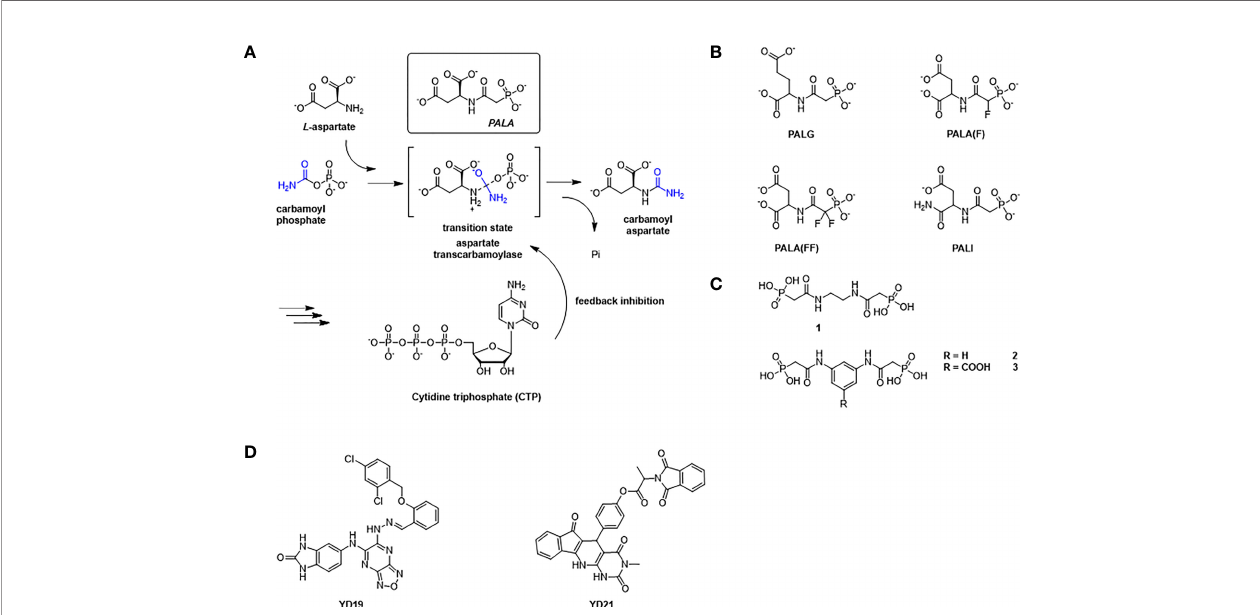
FIGURE 2 | The reaction catalyzed by ATCase and feedback regulation mechanism in de novo pyrimidine biosynthesis pathway, and inhibitors against ATCase. (A) Aspartate Transcarbamoylase (ATCase) combines L-aspartate and carbamoyl phosphate into carbamoyl aspartate through an enzyme stabilized transition state and inhibition feedback by CTP. The ATC inhibitor PALA closely resembles this transition state intermediate. CTP (a product of the pyrimidine biosynthesis pathway) provides feedback inhibition of ATC activity. (B) Structures of PALA analogues as E. coli ATCase inhibitors. (C) Structures of T-state inhibitors against E. coli ATCase that prevent the allosteric transition. (D) Structures of allosteric inhibitors of hu ATCase ( Lei et al.,